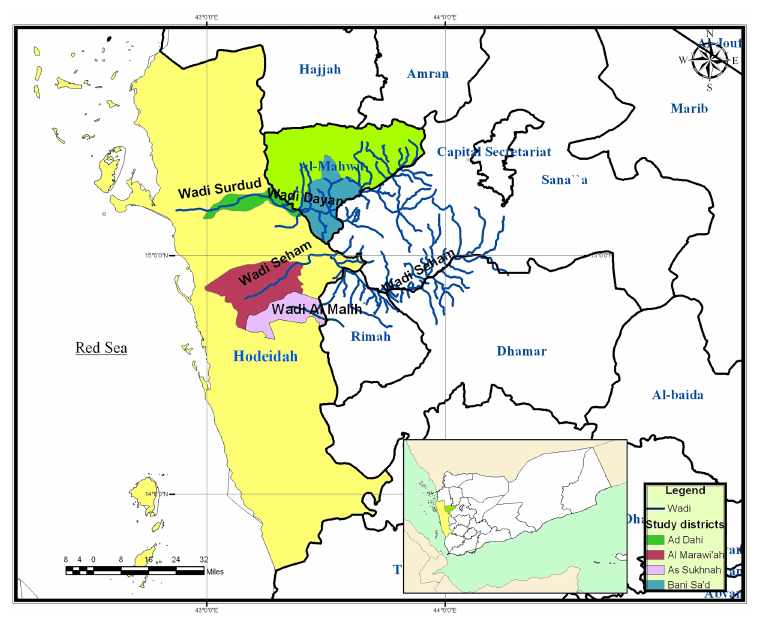
Fig 1. Map of the study